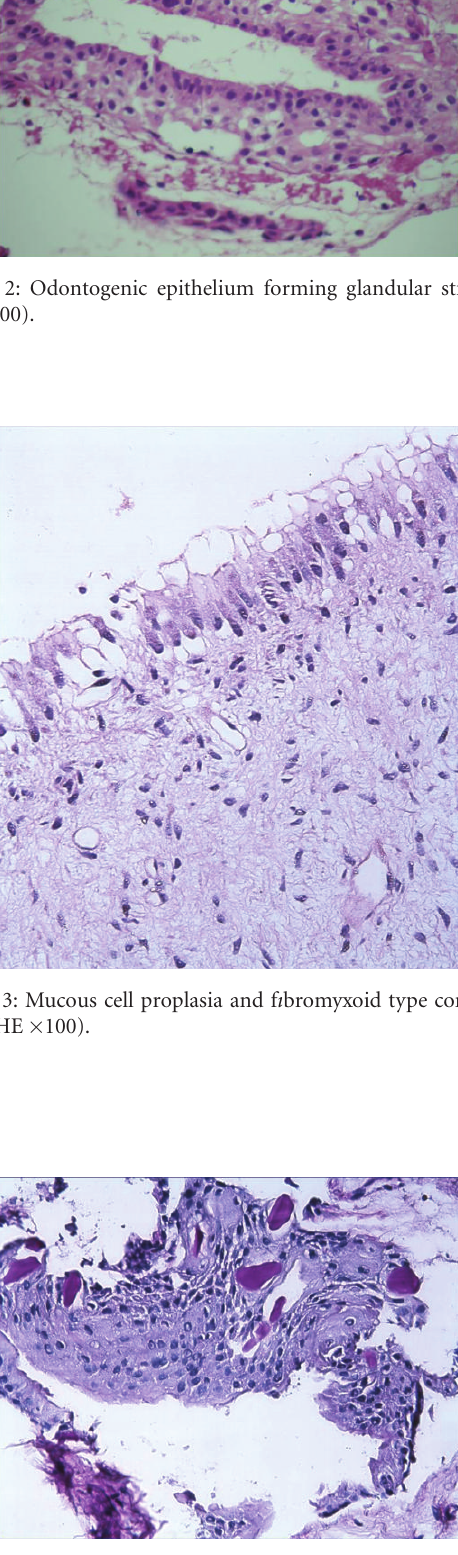
Figure 4: Squamous epithelium with pas positive globular for- mation-(PAS × 100).